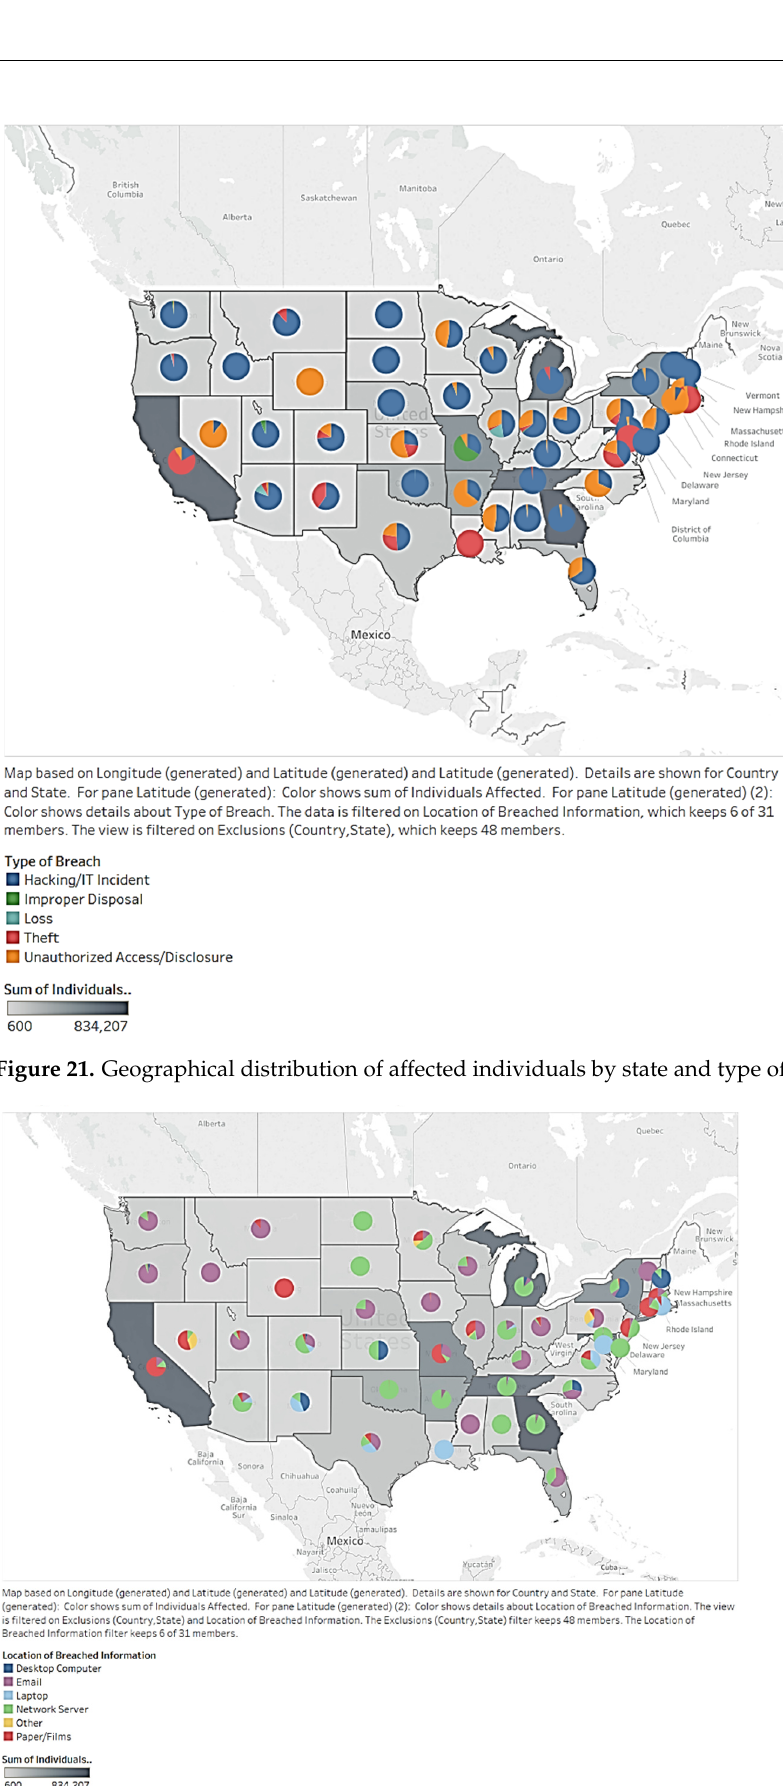
Figure 23. Distribution of affected individuals’ breach location in selected states. In Figure 24, the different colors show the number of affected individuals. Darker shades signify a higher number of records. The heat map details the covered entity type. For affected states (i.e., CA, TN, SC, and MO), most show that healthcare providers dom- inate. Only CA has health plans as the majority type. The business associate entity was randomly distributed throughout the states. Most states affected by data breaches listed the healthcare provider entity. States on the west and east coasts listed the business asso- ciate entity. This may be due to the improved economic situations along the coasts as compared to the middle of the country.